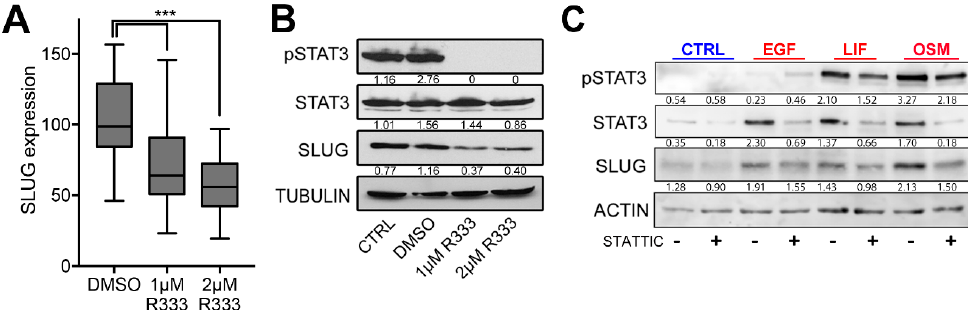
Figure 3. Cont . Figure 3.